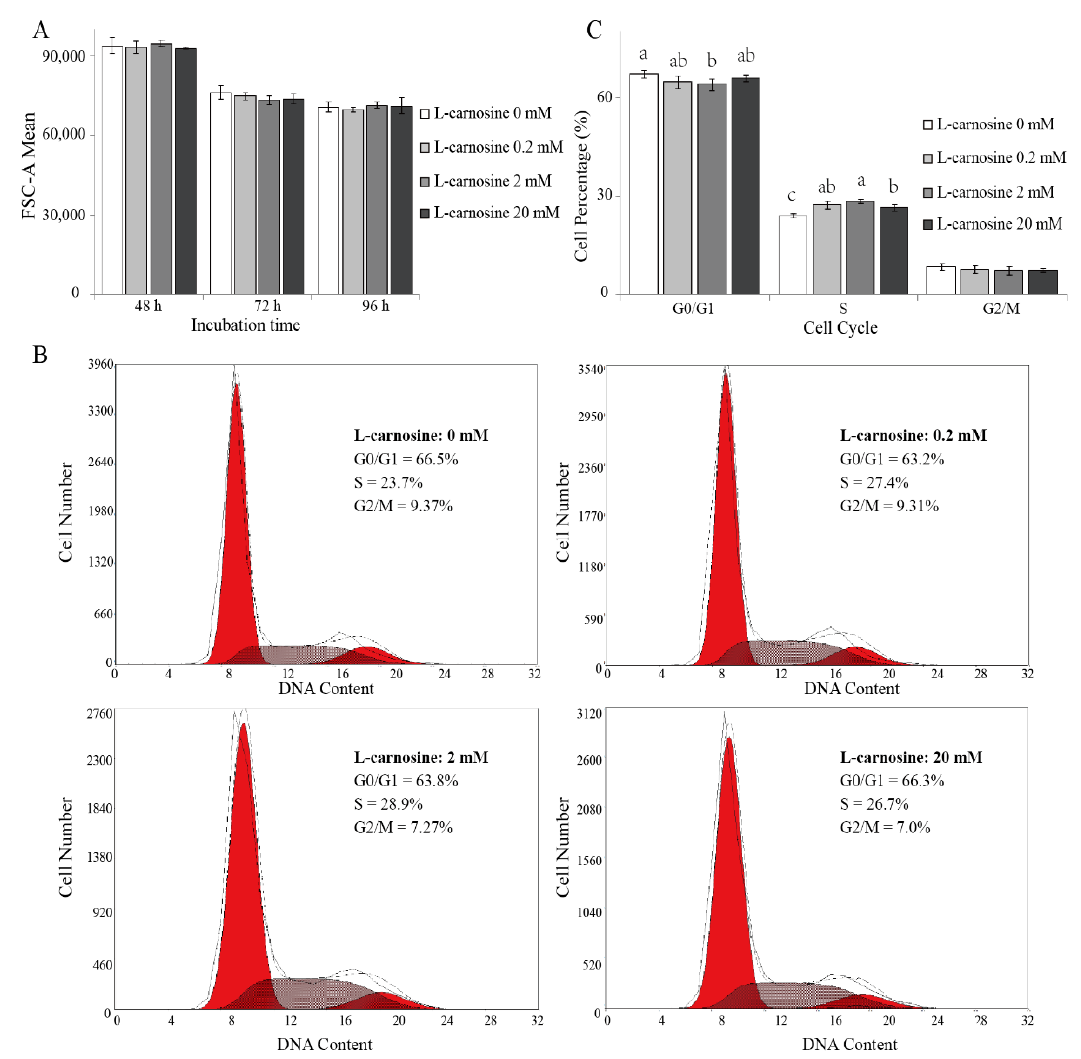
Figure 4. Effect of L-carnosine on cell size and cell cycle in piglets’ SCs in vitro ( n = 5). The effect of L- carnosine on SC size ( A ) and cell-cycle distribution at 72 h ( B , C ). L-carnosine (0, 0.2, 2, and 20 mM), growth medium supplemented with different concentrations of L-carnosine (0, 0.2, 2, and 20 mM). FSC-A, forward scatter area; G0, resting phase; G1, first gap; S, synthesis phase; G2, second gap; M, mitotic phase. The data are expressed as mean values ± SD. Means with different superscript letters (a–c) indicate significant differences at p <